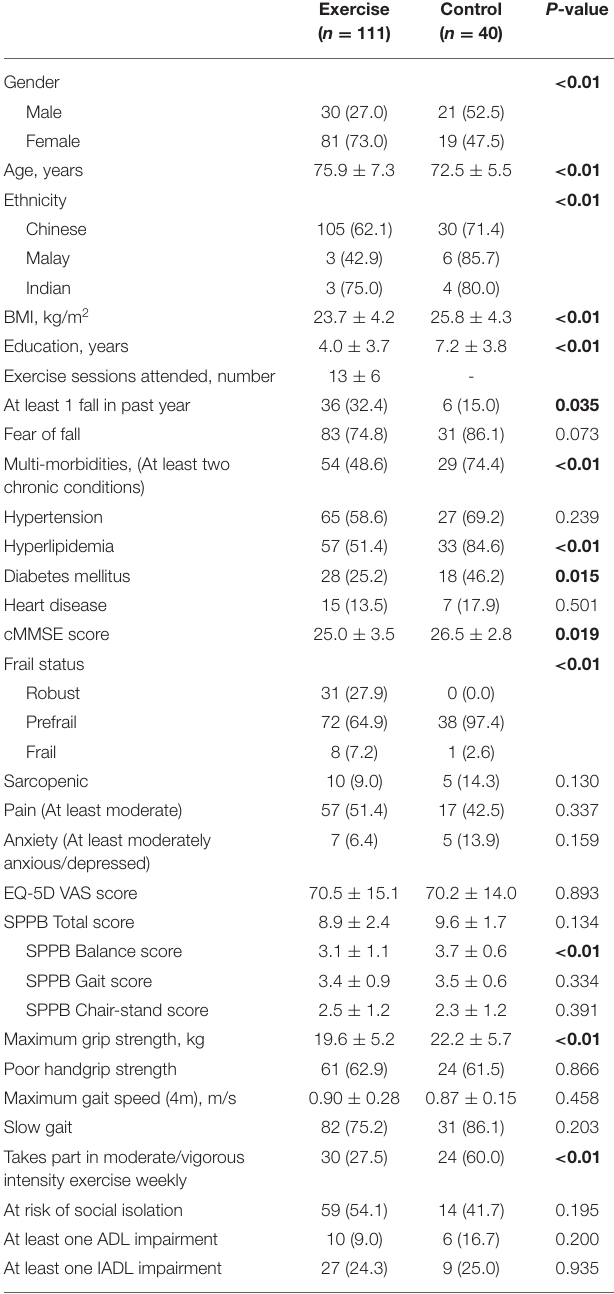
TABLE 1 | Baseline characteristics of participants in exercise and control